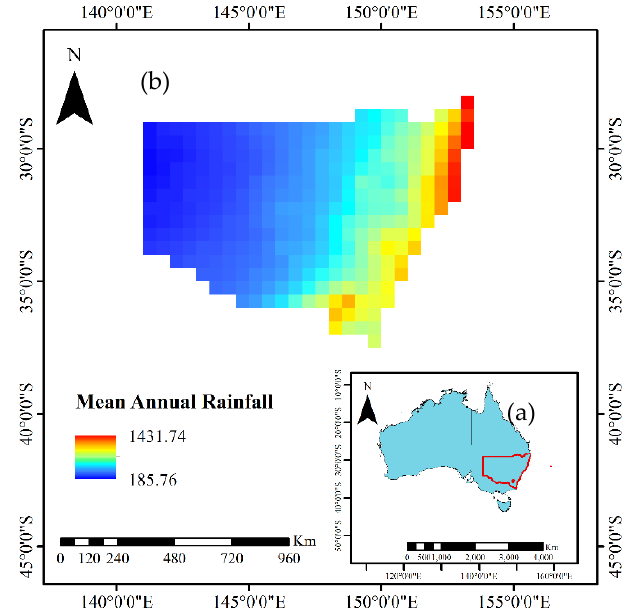
Figure 1. ( a ) Study area in Australia, and ( b ) mean annual rainfall of NSW (1901–2018) based on Climatic Research Unit–Time Series (CRU - TS) dataset. Table 1. Input parameters used for drought